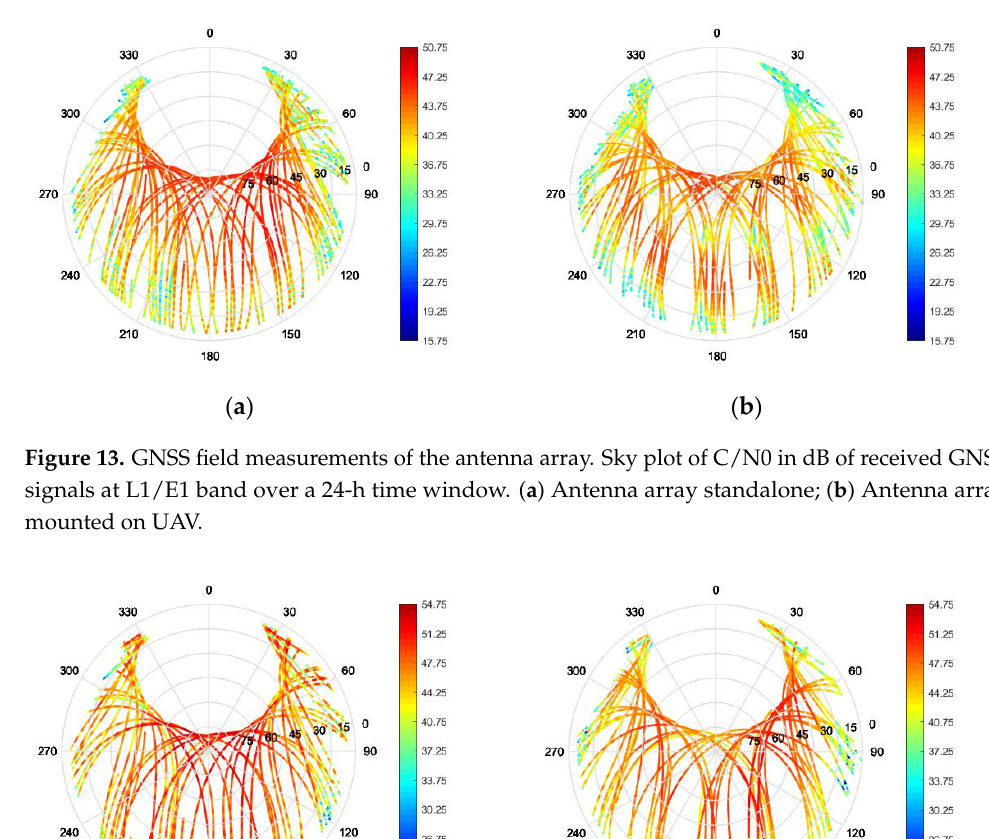
Figure 12. GNSS field measurements of the antenna array. ( a ) Standalone; ( b ) Antenna array mounted on UAV. Measurements were performed at exact same location and height above ground, only photographed from slightly different angles.